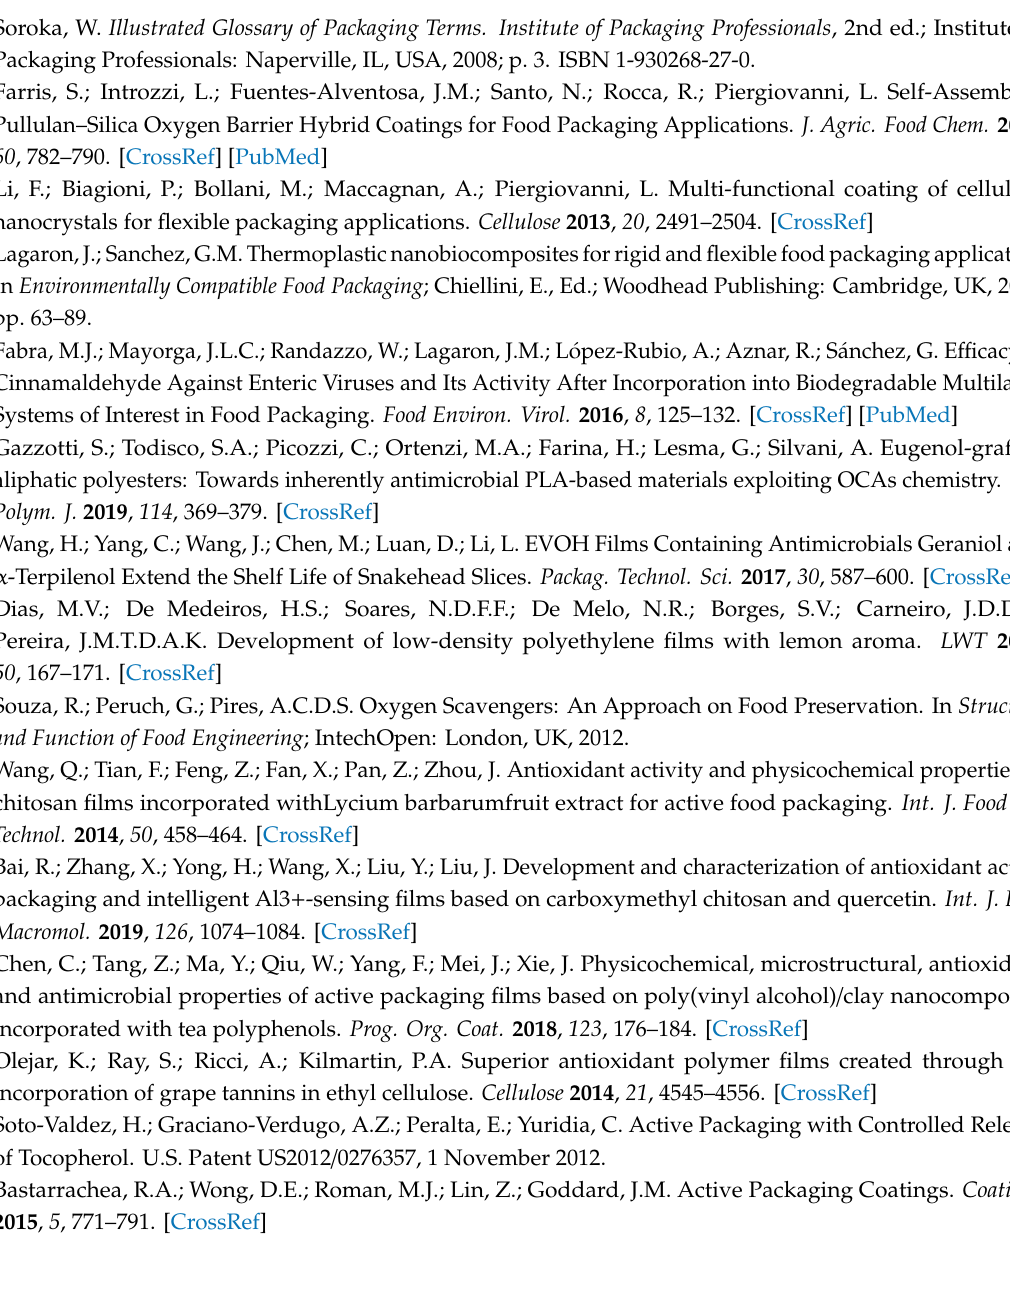
Figure S1: SEC curves of PLA-Tyr, PLA-Pyr, PLA-DBA, PLA-AA. Figure S2: DSC thermograms of PLA-VA and 4043D